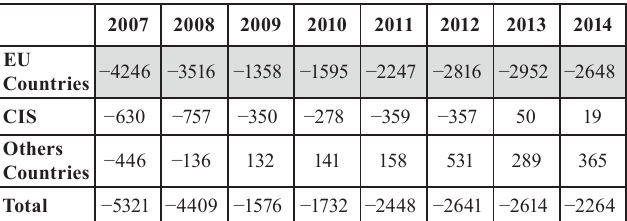
Foreign Trade Balance of Latvia with the EU Countries, CIS and Others, Million EUR